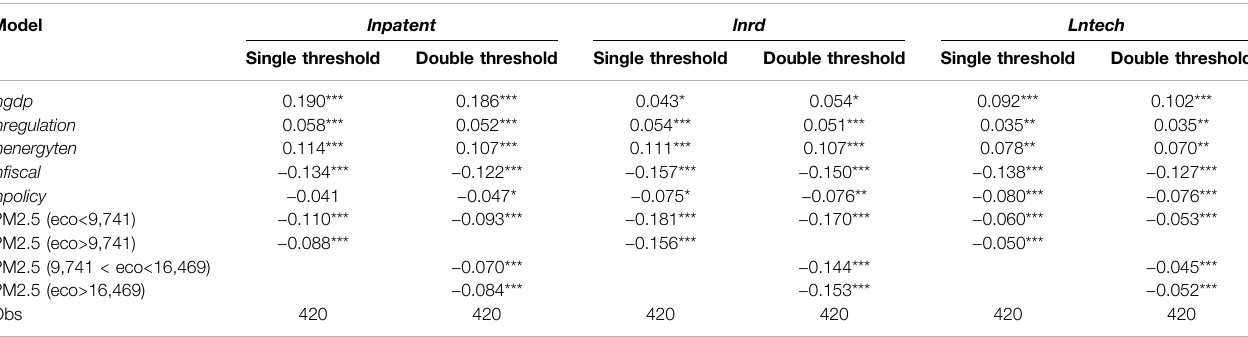
TABLE 9 | Threshold model